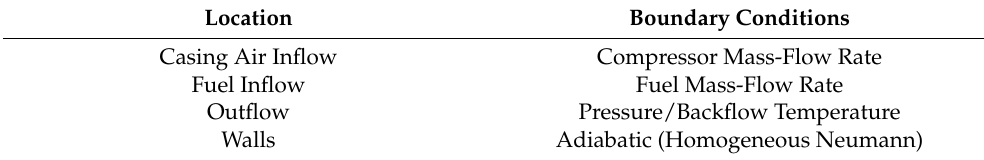
Table 2. Boundary